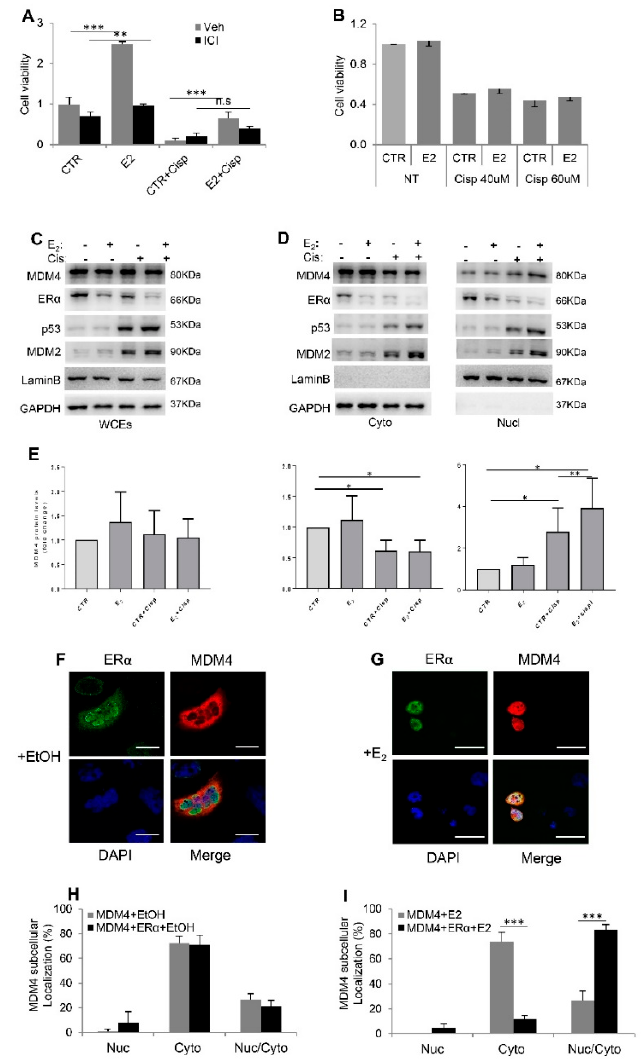
Figure 3. E 2 alters MDM4 subcellular localization. ( A , B ) Relative cell viability of MCF-7 ( A ) and MDA-MB-231 ( B ) by cell titer assay. Graphs show mean ± SD of two experiments performed in tetraplicate (Two-tailed unpaired t -test, ( A ) CTR vs. E 2, t = 13.45, df = 4, *** p = 0.0002, CTR + Cisp vs. E 2 + Cisp, t = 18.29, df = 8, *** p < 0.0001, CTR + ICI vs. E 2 + ICI, t = 4.834 df = 6, ** p = 0.0029, CTR + Cisp + ICI vs. E 2 + Cisp + ICI, t = 2.284, df = 6, p = 0.0624). ( C , D ) WB analysis of whole cell extracts (WCEs) ( C ) and cytoplasmic (Cyto) and nuclear extracts (Nucl) ( D ) of MCF-7 cells treated as indicated. Laminin and GAPDH were used as LC. ( E ) MDM4 levels under indicated treatments, relative to the untreated cells (CTR) arbitrarily set to 1 and corrected to the respective loading control. Mean ± SD of 4 independent biological replicates is shown (One sample t -test, Cyto graph: CTR + Cisp vs. CTR, DF = 3, t = 4.48, * p = 0.021, E 2 + Cisp vs. CTR, DF = 3, t = 4,328, * p = 0.023; Nucl graph: CTR + Cisp vs. CTR, DF = 3, t = 3198, * p = 0,0494, E 2 + Cispl vs. CTR, DF = 3, t = 4.034, * p = 0.0274; E2 + Cisp vs. CTR + Cisp Paired t -test DF = 3, t = 6.451, ** p = 0.0076). ( F , G ) Representative pictures of ER α (green) and MDM4 (red) exogenously expressed in A2780 cells treated as indicated for 20 h. Nuclei were counterstained with DAPI (blue) (scale bars, 50 µ m). ( H , I ) Graphs show the percentage of A2780 cells showing only Nuclear (Nuc) or Cytoplasmic (Cyto) or Nuclear and Cytoplasmic (Nuc / Cyto) MDM4 signal relative to the total number of positive cells. Mean ± SD of 3 independent biological replicates is shown (Two-tailed unpaired t -test, ( I ) Cyto MDM4 + E 2 vs. Cyto MDM4 + ER α + E 2, t = 13.13, df = 4, *** p = 0.0002, Nuc / Cyto MDM4 + E 2 vs. Nuc / Cito MDM4 + ER α + E 2, t = 11.08, df = 4, *** p =